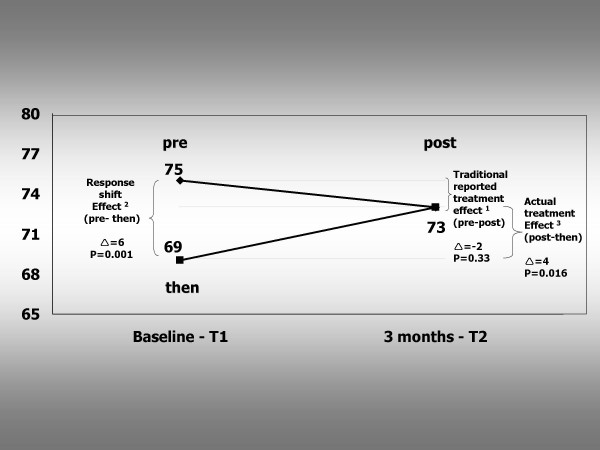
SEIQoL Index scores at baseline (T1) and after three months (T2). 1The traditional reported treatment effect = post-test minus pre-test score 2The response shift effect = pre-test minus then-test score 3The actual treatment effect = post-test minus then-test score